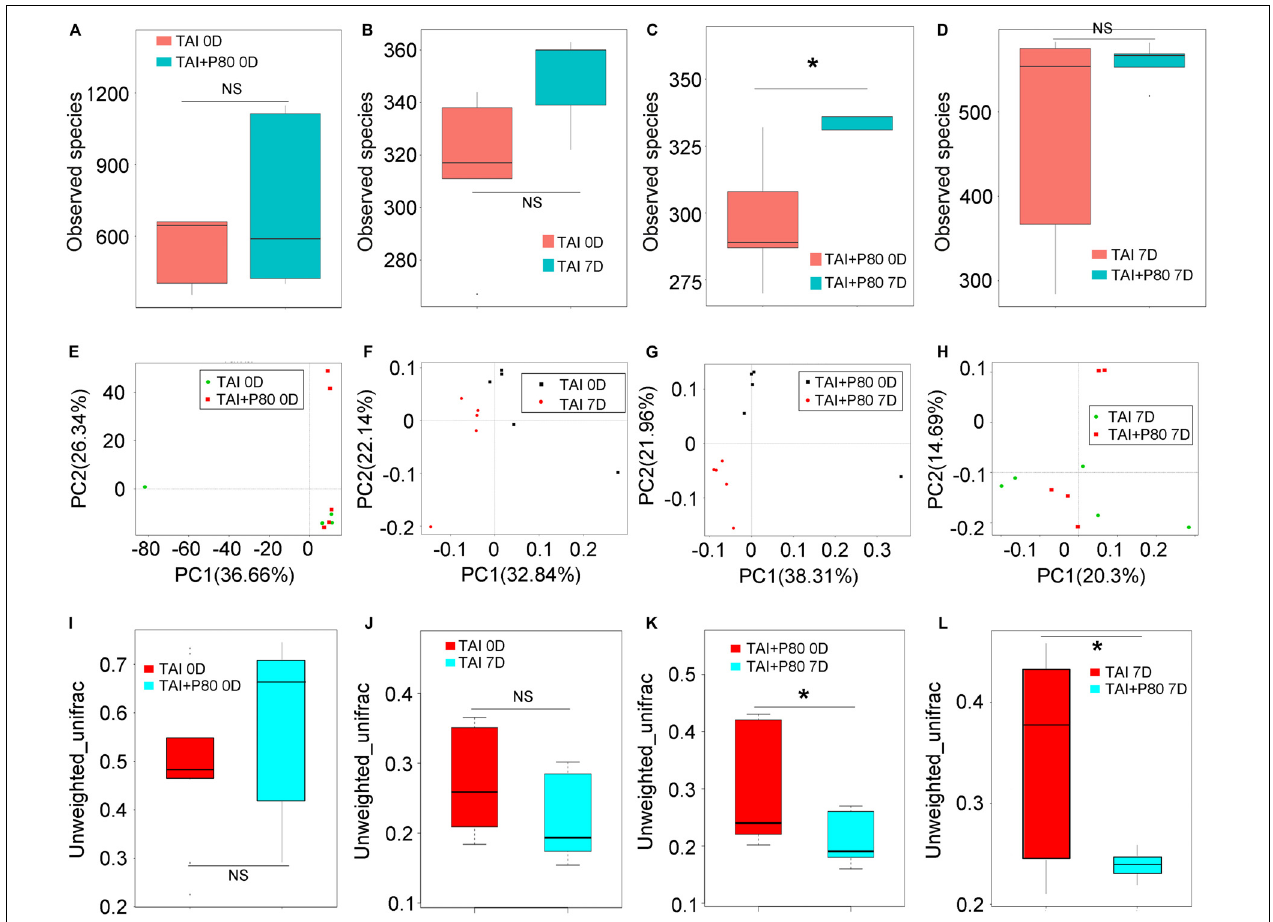
FIGURE 3 | P80 alters the gut microbiota composition of irradiated mice. (A–D) The observed species number of intestinal bacteria was examined by 16S rRNA sequencing before (or at 7 days after) 12 Gy TAI. Mice were treated with water (TAI group) or P80 (TAI+P80 group), respectively. Statistically significant differences are indicated: none significance (NS), * p < 0.05; TukeyHSD, n = 5 per group. (E–L) The PCA (E–H) and β diversity (I–L) of intestinal bacteria in mice before (or at 7 days after) TAI were examined by 16S rRNA sequencing. The top and bottom boundaries of each box indicate the 75th and 25th quartile values, respectively, and lines within each box represent the 50th quartile (median) values. Ends of whiskers mark the lowest and highest diversity values in each instance. Statistically significant differences are indicated: none significance (NS), * p < 0.05; TukeyHSD, n = 5 per